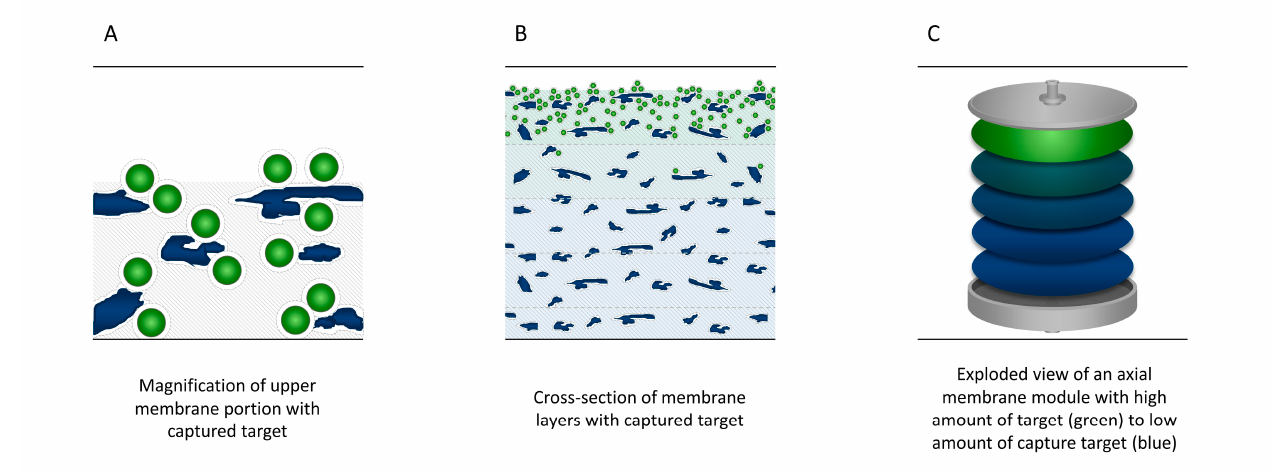
Figure 4. Capture of the target on the upper membrane layers. ( A ) Magnification of upper membrane portion, as shown in Figure 2. ( B ) Cross section of membrane layers with captured targets. More of the target was found on the first membrane layer. ( C ) Visualization of the captured target on the membrane. A decreasing amount of the target from the upper to bottom membrane layer was observed (high target amount = green, low target amount = blue).